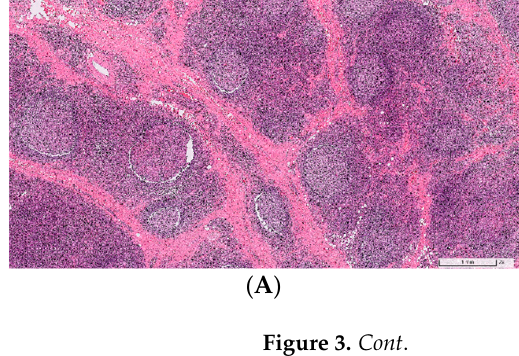
Figure 2. High-resolution computed tomography with head and upper neck enhancement in Case 2. The image revealed subcutaneous nodular lesions (arrows) in the bilateral postauricular region (dimensions, right: 15 mm × 7 mm; left: 17 mm × 12 mm) with relatively ill-defined margin and increased stranding of adjacent subcutaneous fat.